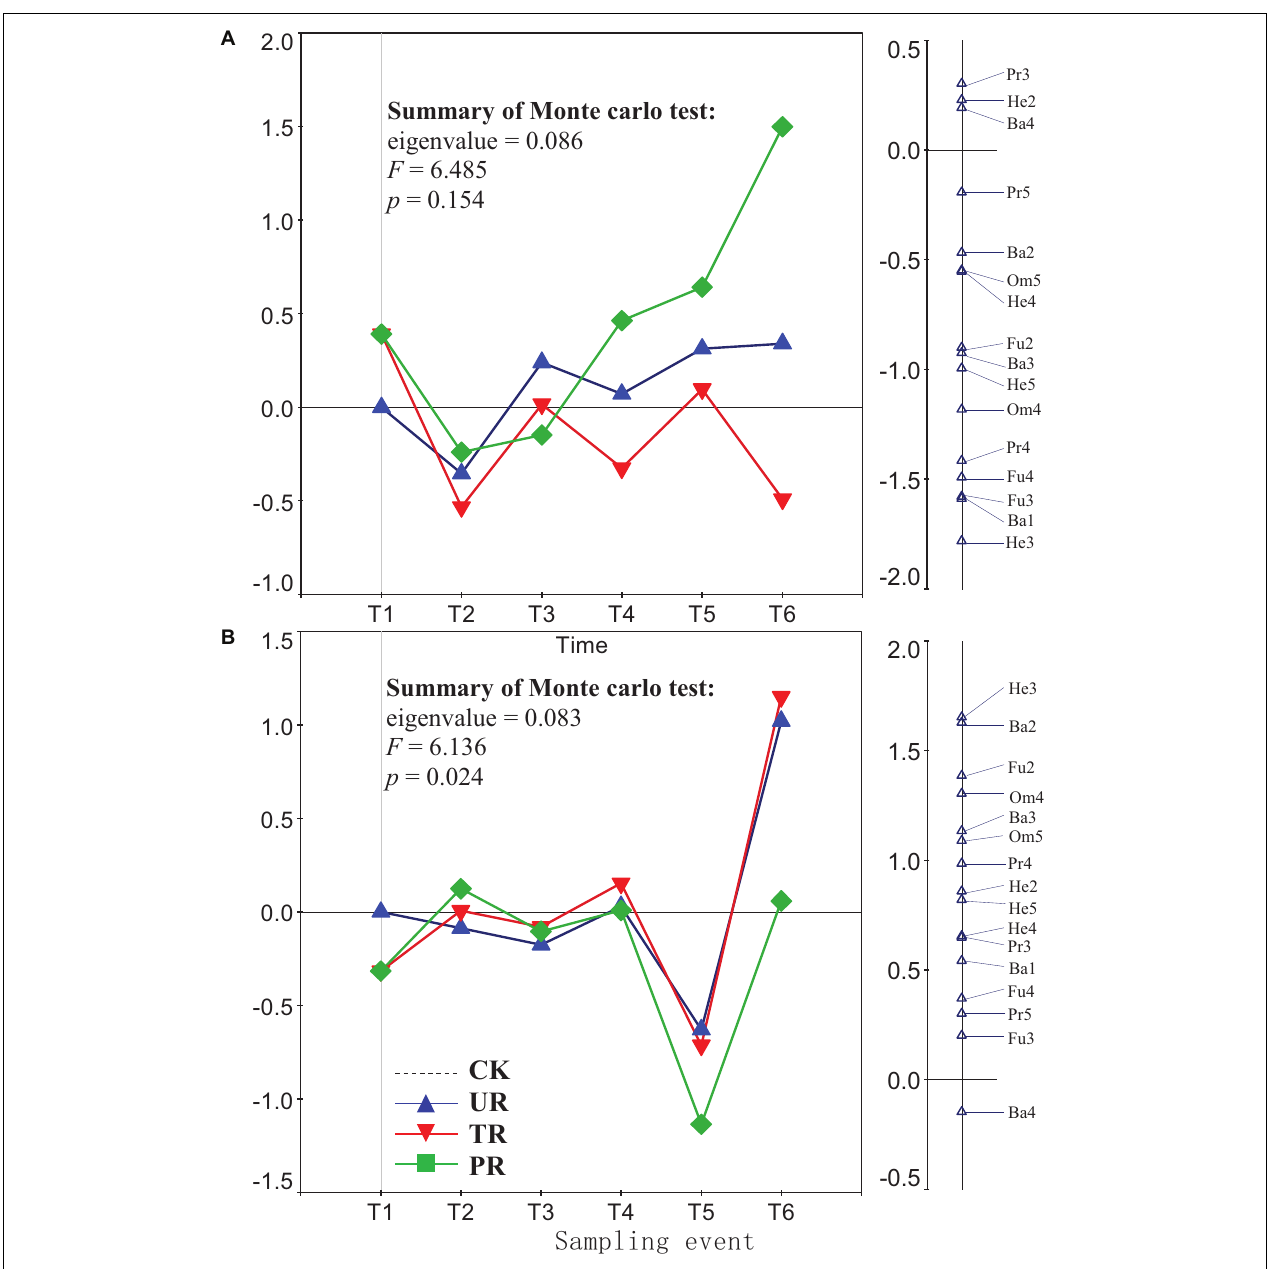
FIGURE 2 | Principal response curves (PRC) with weights of abundance of nematode functional guilds in control (CK), understory removal (UR), tree removal (TR), and all plant removal (PR) plots at (A) 0–5 cm and (B) 5–10 cm soil depths across six sampling events. The bi-plot on the left side representing temporal trajectories of nematode community for each of the treatments (CK, UR, TR, and PR). The vertical graph on the right side showing the nematode functional guild scores. The horizontal dotted line represents the control treatment. At each sampling event, the greater the deviation of a response curve (treatment curve) from horizontal line, the greater the differences of nematode communities between the treatment and control. T1–T6 are 10 days before and 8, 37, 162, 258, and 379 days after vegetation removal treatments were applied, respectively. The deviation of abundance of a nematode functional guild from the control at a sampling time can be calculated with the equation: exp(value in curve × value of functional guild score on the first RDA axis). Particularly, values > 1 indicate increase in the abundances of nematode functional guilds relative to CK, and values < 1 indicate decreases in abundances of functional guilds relative to CK. Soil nematode functional